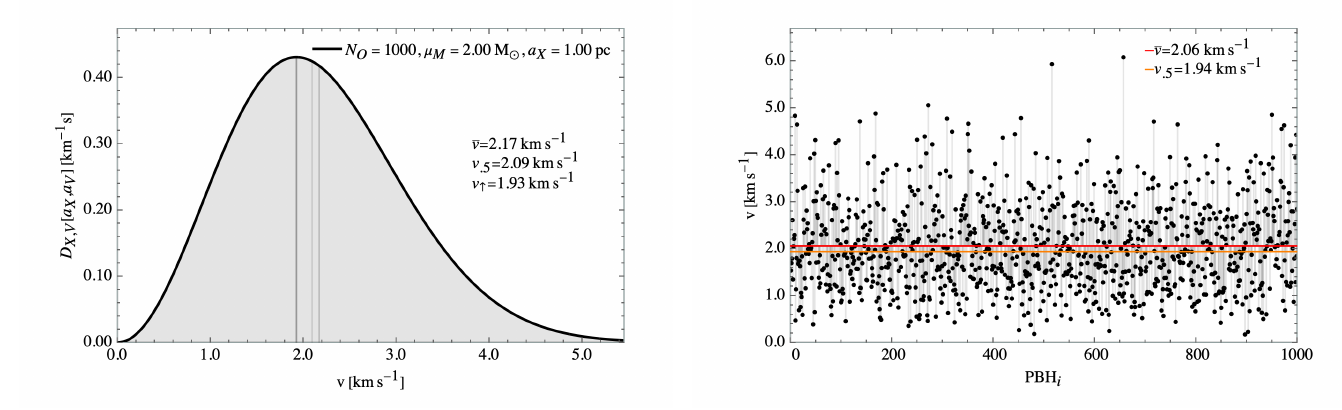
Figure 6. Velocity IC distribution profile from computed from Table 1 and an example realisation, from the mean µ v = 2.0km/s and scale parameter a v = 1.2km/s. The thick, normal and thin grey lines signal the distribution mode, median and mean respectively. The orange and red lines signal the realisations median and mean velocities respectively. Note, again, the hierarchy between modal, median and mean masses is much reduced with respect to the mass case, due to the smallness of the v → ∞ tail of the distribution, which results in a small variance of the total simulated velocities in the